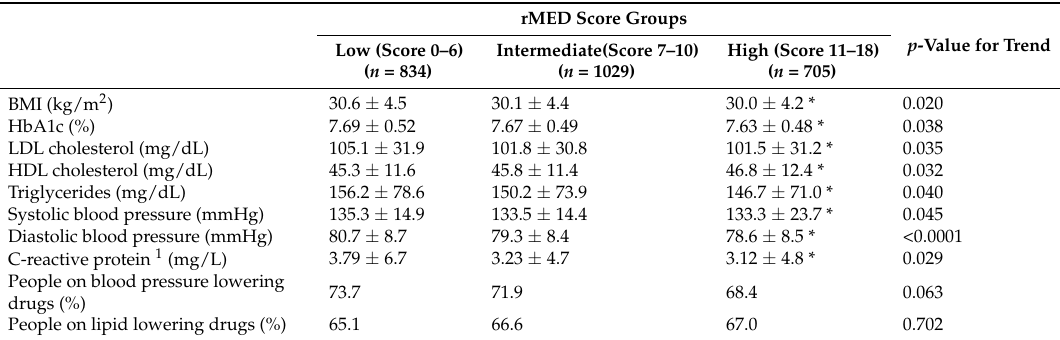
Figure 1. Adherence to the nutritional recommendations for people with diabetes (DNSG [27] and SID [28]) by rMED score. DNSG: Diabetes and Nutrition Study Group; SID: Italian Diabetes Society; SFA: Saturated Fatty Acids; Chol: Cholesterol; CHO: Carbohydrates. Table 4. Cardiovascular risk factors profile by rMED score groups.